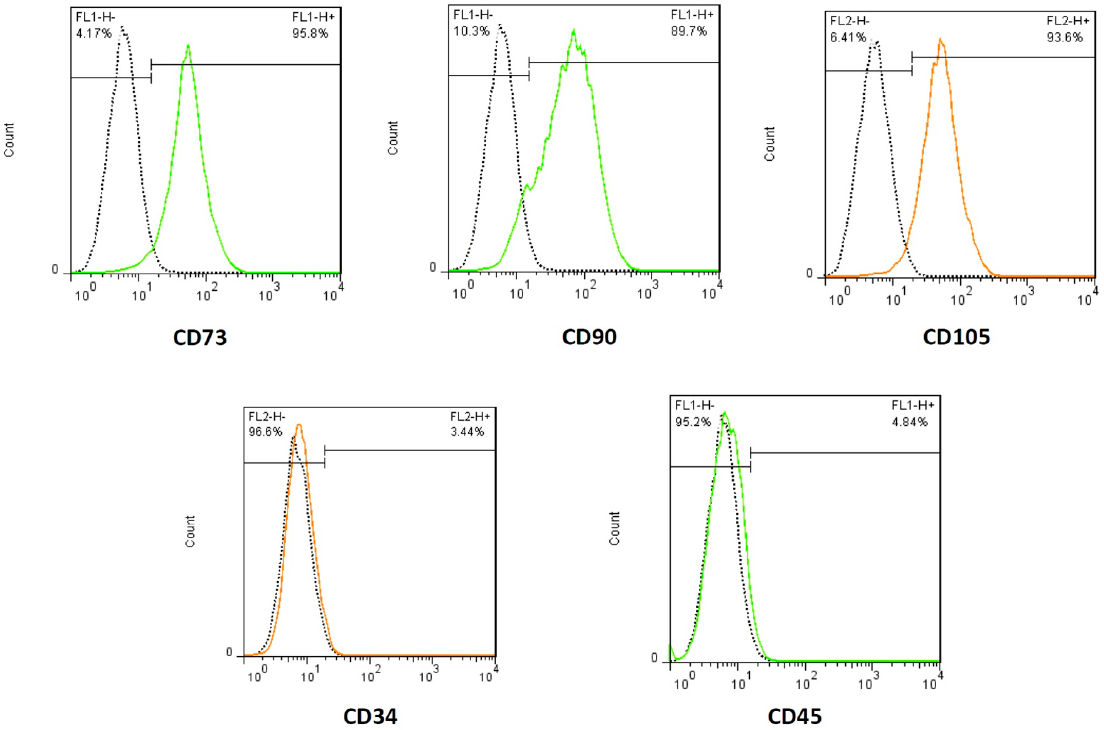
Figure 3- Flow cytometric characterization of hDPSCs. hDPSCs positively expressed CD73, CD90, and CD105 and did not express CD34 and